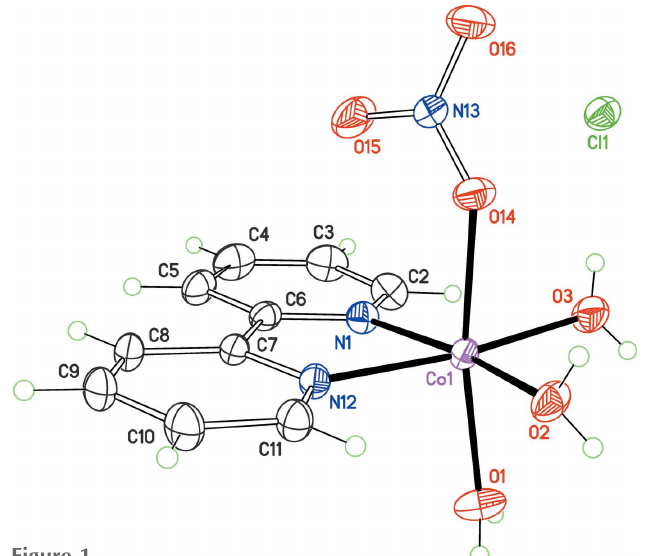
Figure 1 The structure of the complex cation and the anion in the title compound, with displacement ellipsoids for non-H atoms at the 30% probability